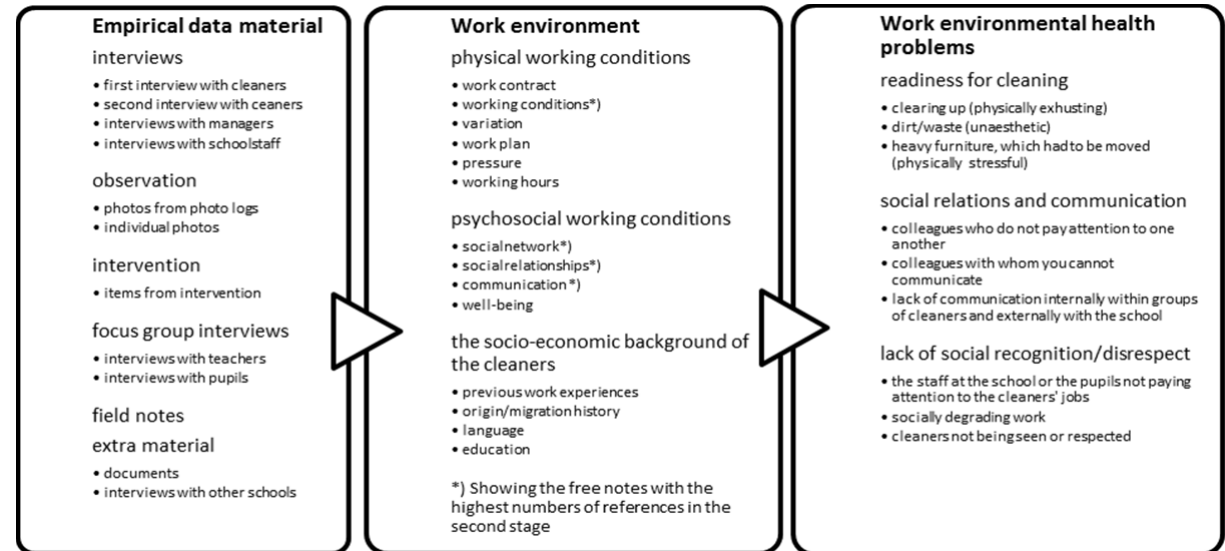
Figure 1. The coding